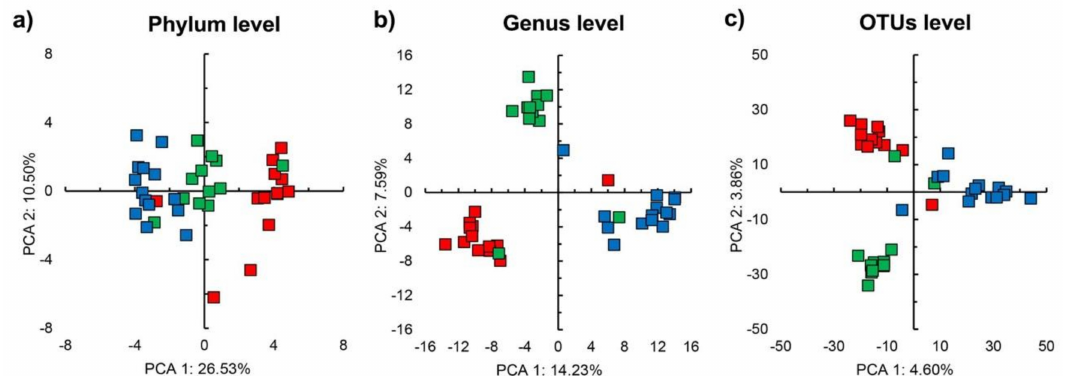
Figure 3. Principal component analysis (PCA) with centered log-ratio transformed count numbers of ( a ) all bacterial phyla, ( b ) all bacterial groups assigned up to the taxonomic level of genus and ( c ) all operational taxonomic units (OTUs) in unamended soil with electrolytic conductivity (EC) 1.9 dS m − 1 ( (cid:4) ) EC 17.3 dS m − 1 ( (cid:4) ), and EC 33.4 dS m − 1 ( (cid:4)